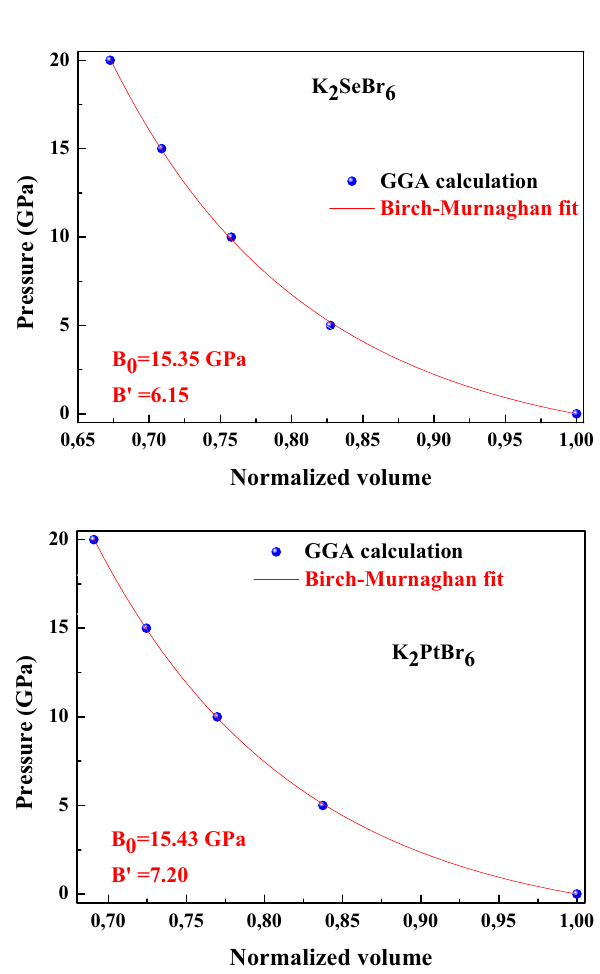
Figure 2. The pressure effect on normalized volume in K 2 SeBr 6 and K 2 PtBr 6